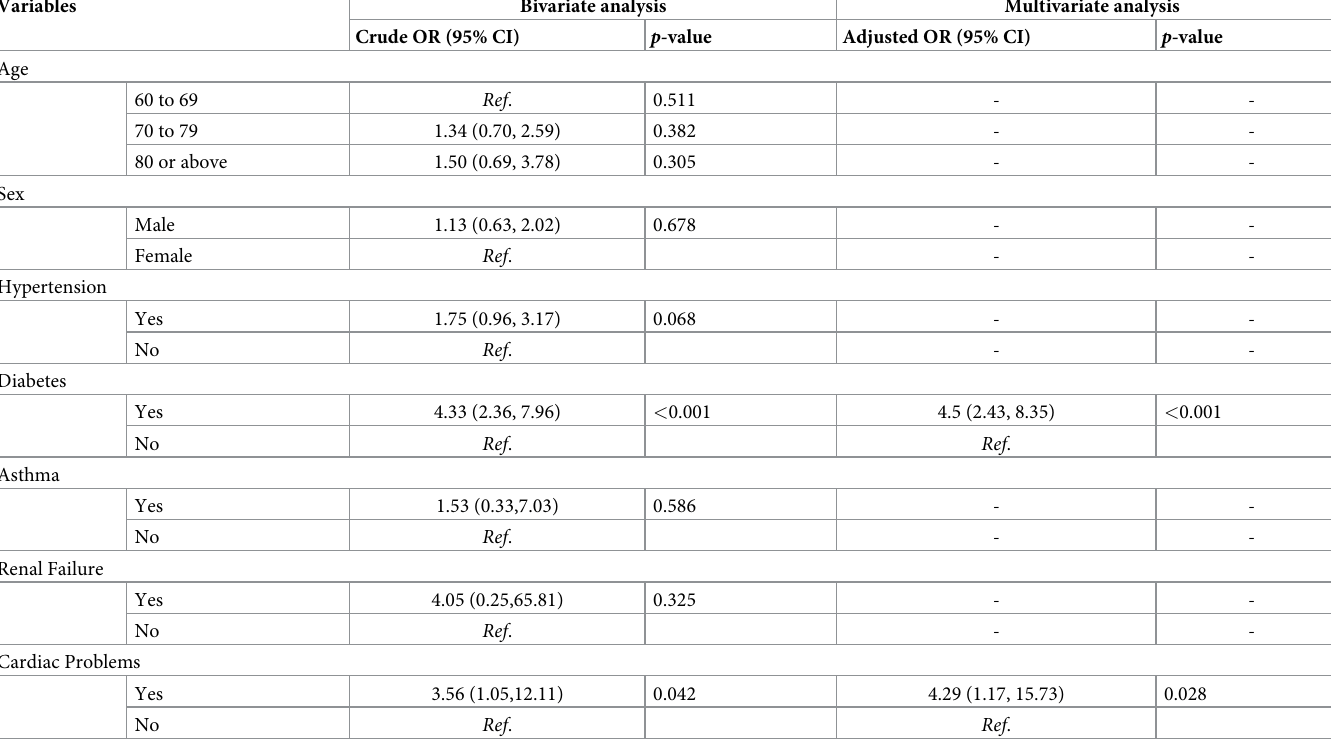
The NSAIDs with the greatest risk of drug interactions were aspirin (n = 168), indometha- cin (n = 52), ibuprofen (n = 46) and diclofenac tablet (n = 41). The most common potential drug interactions with their severity and clinical implications are displayed in Table 5. Chi-square test for trend analysis indicated there was significant increase in interaction with increase the number of drugs prescribed ( χ 2 = 20.72, P < 0.001). As the number of drugs prescribed increases by one unit, the odds of interactions increase by 3.25 unit (COR: 3.25; 95%CI: 1.89, 5.61) [Table 6]. Table 3. Association of polypharmacy with age, gender and chronic